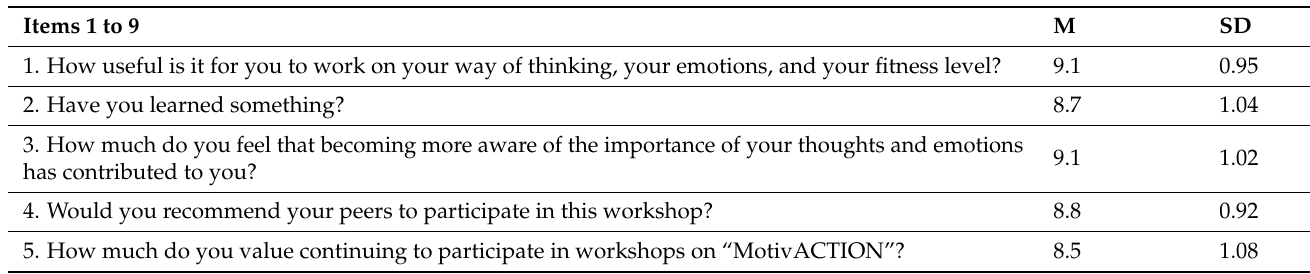
Table 3. Questionnaire